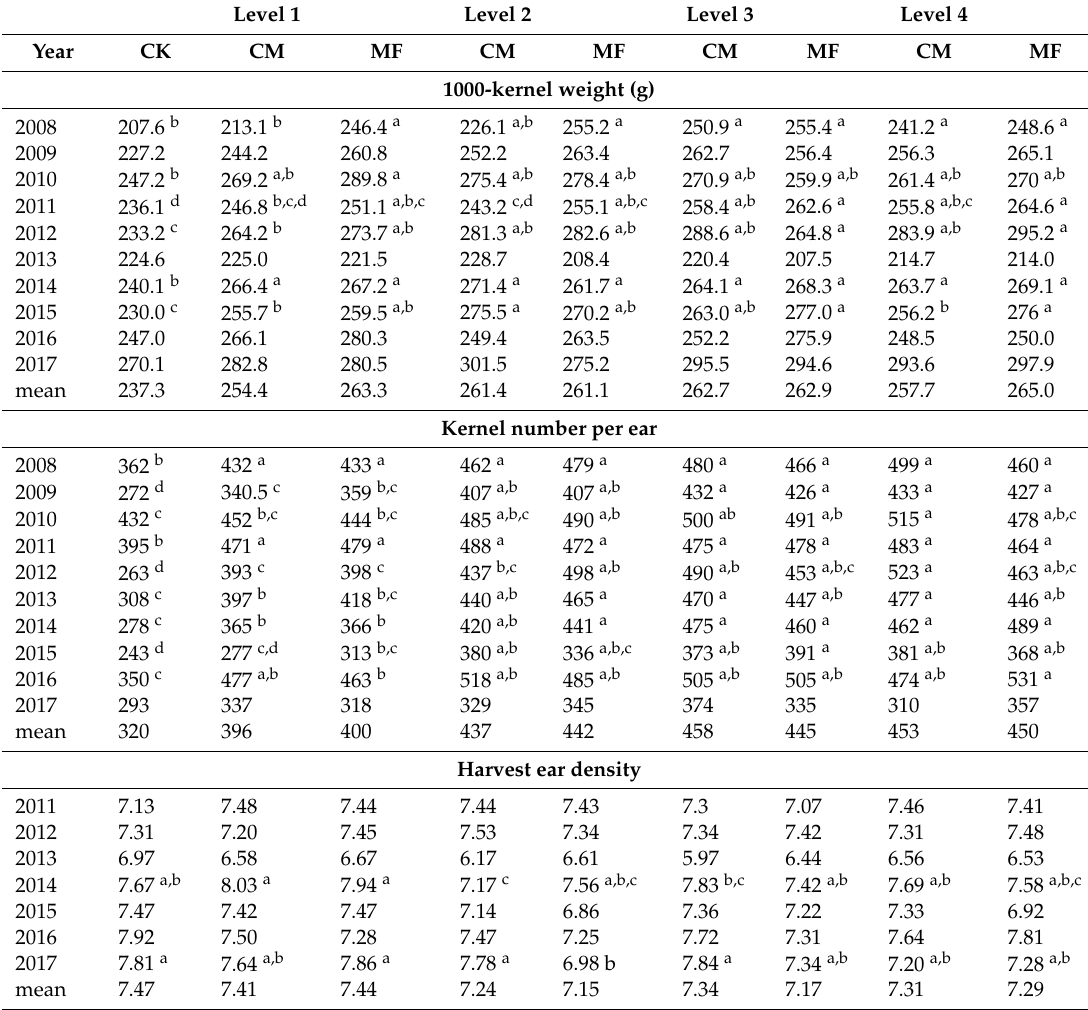
Table 3. Maize yield components in response to two types of fertilizers (CM and MF) and four application